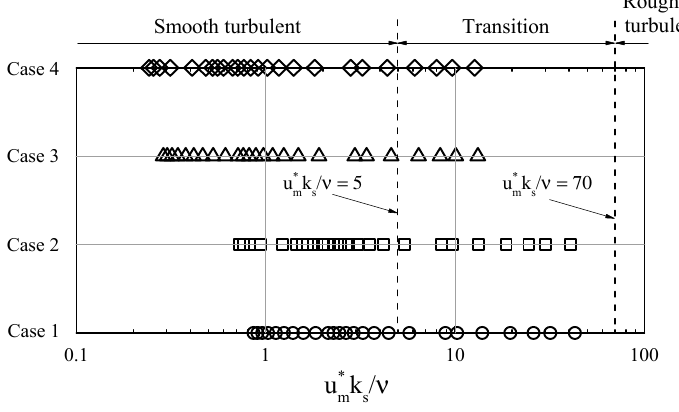
Figure 6. Transition from smooth to rough turbulent regime.